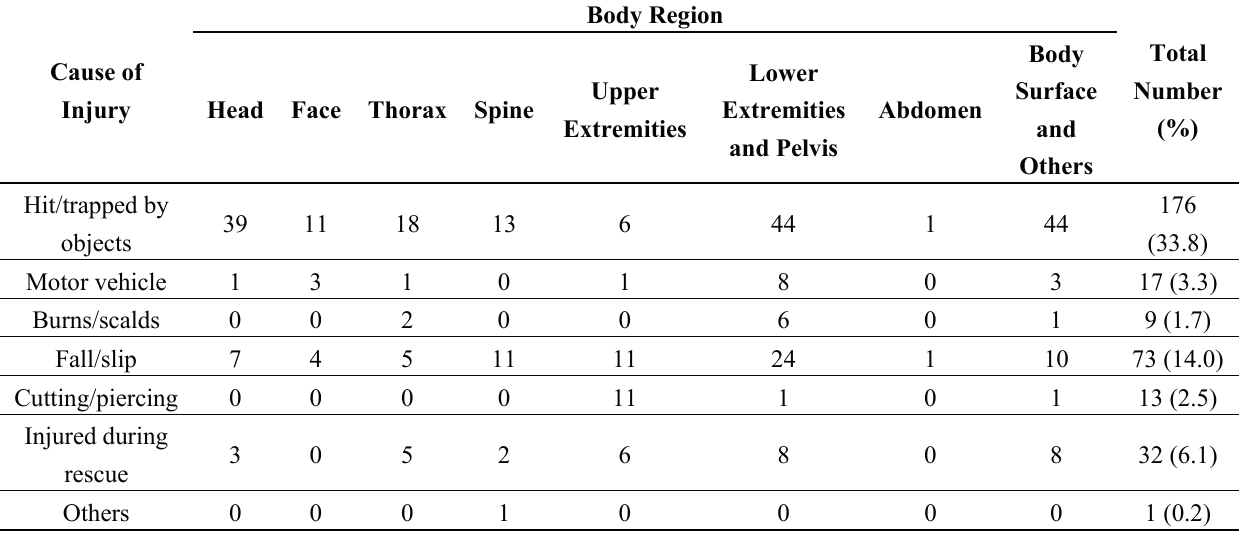
Table 3. Cause of injury by body region of 521 injury diagnoses in admitted patients with earthquake-related injuries.